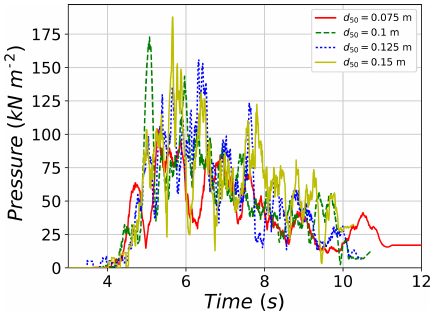
√ Figure 24. Maximum impact pressure and average number of con- k 1 /k 2 = 0 . 3 and tacts for different simulations with different d 50 , using φ b = 30 ◦ , √ k 1 /k 2 = 0 . 3 and α = 30 ◦